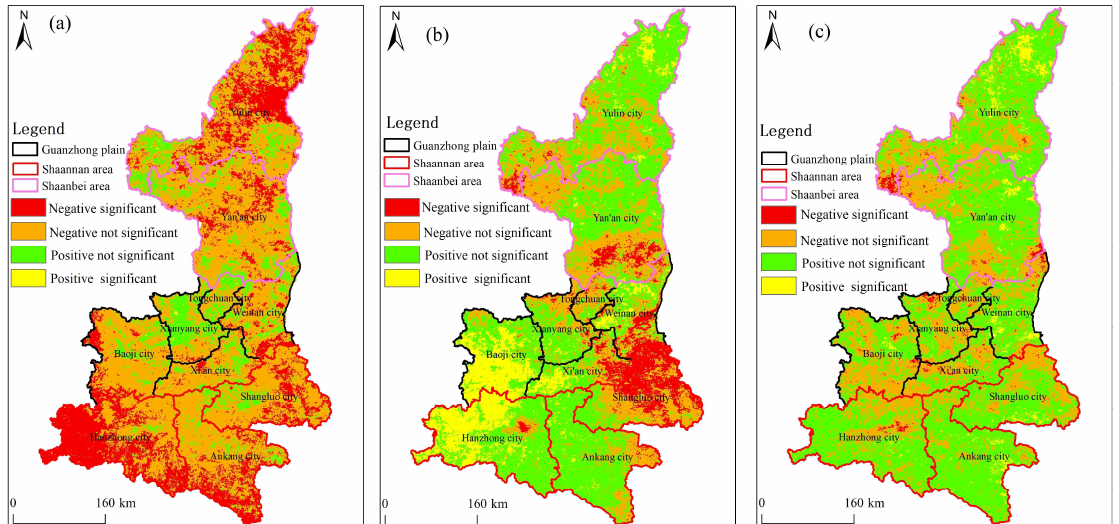
Figure 12. Comparison of GSSIM and linear regression analysis. ( a ) GSSIM between 2000 and 2016. ( b ) Significant linear regression slope values for trends derived from TVDI observations during 2000–2016 (reliable at 5% significance level).